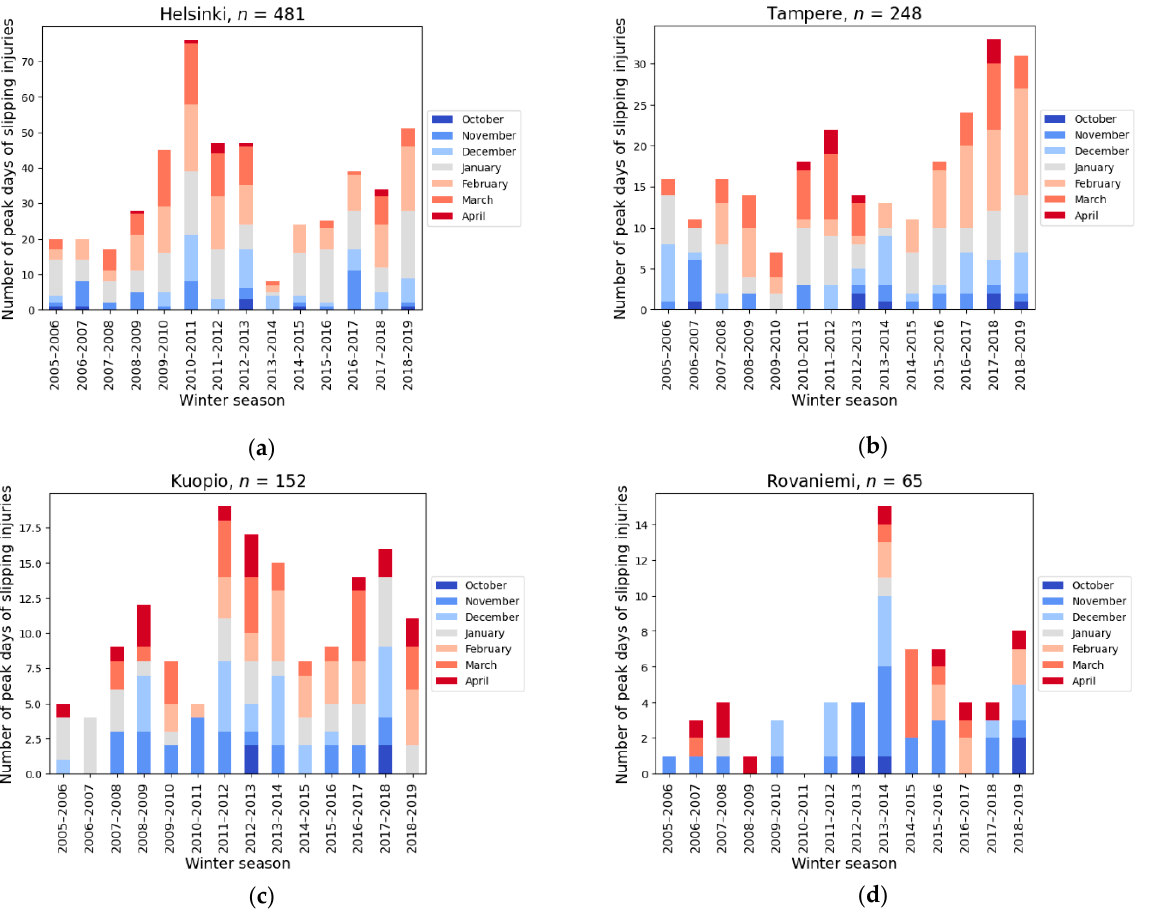
Figure 4. The monthly distributions of the peak days on different winters for Helsinki ( a ), Tampere ( b ), Kuopio ( c ) and Rovaniemi ( d ) between the years 2005 and 2019. The number of peak days ( n ) is shown for each city. Figures for all cities are presented in the Supplementary Material (Figure S2).